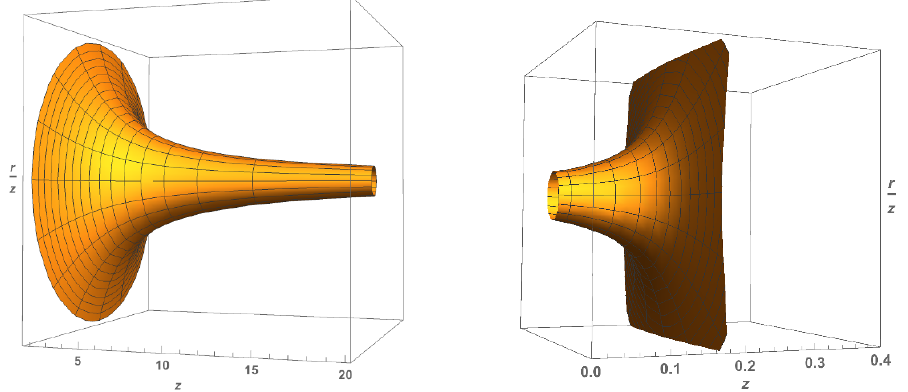
Figure 1 . The two types of D3-brane embeddings in AdS 5 . Shown above are the proper sizes of the two-sphere wrapped by the D3-branes as a function of AdS radial coordinate z . The (cid:12)gure on the left represents an interpolation between the symmetric representation in the UV ( z ! 0) and an IR spike of k strings, while the one on the right is the symmetric representation source ending on a Coulomb branch